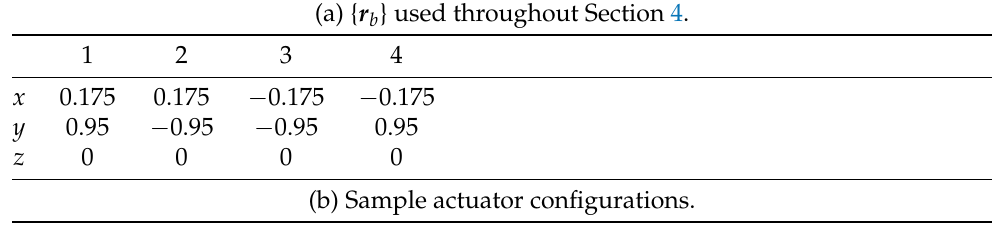
Figure 7. The moored barge in various poses and with the horizontal required workspace η indicated. Green and yellow colours indicate trajectories in two different test runs. Table 2. Sample actuator and platform configurations used in Section